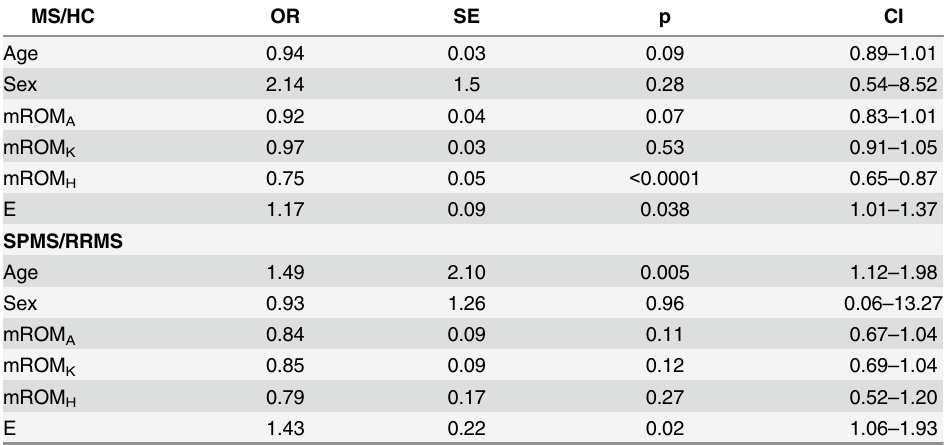
Table 3. Multivariable Models: Association Between Kinematic Parameters and MS Disease. MS/HC